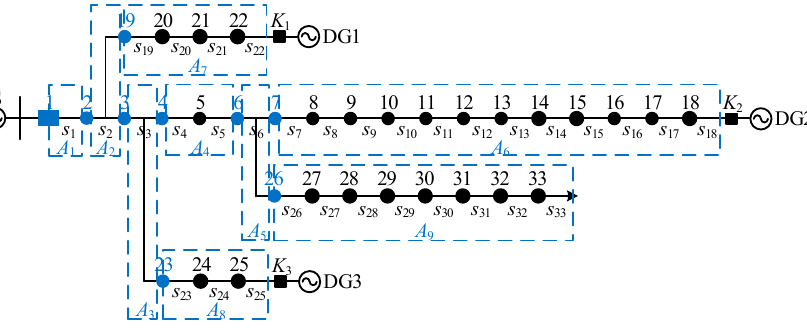
Figure 6. IEEE 33-node distribution network.